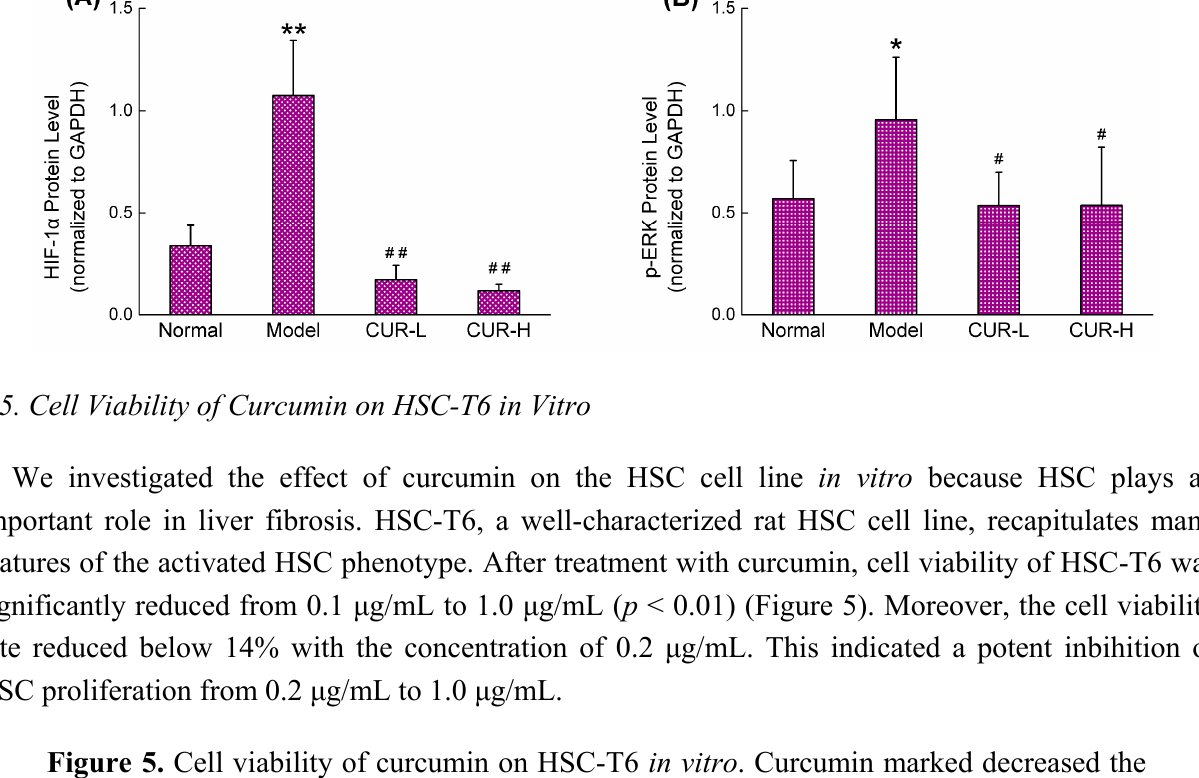
Figure 5. Cell viability of curcumin on HSC-T6 in vitro . Curcumin marked decreased